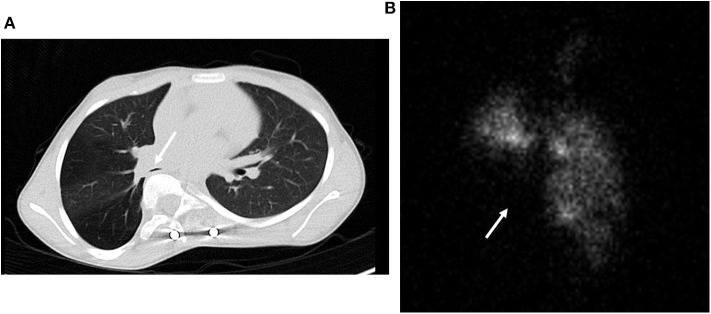
(A) CT scan of lobar bronchial compression by the spine due to scoliosis and vertebral intrusion into the thorax. (B) Lung ventilation scan correlated with the CT scan in (A) demonstrating loss of ventilation in the right middle and lower lobes.